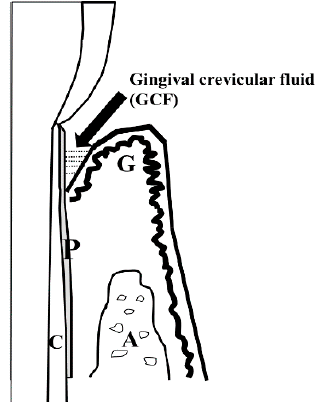
Figure 1. Schematic view of Gingival Crevicular Fluids (GCF). The GCF components may include breakdown products of host epithelial and connective tissues, factors produced by host cells in the periodontium, and products derived from subgingival microbial plaque. A, Alveolar bone; C, Cementum; G, Gingiva; P, Periodontal ligament.